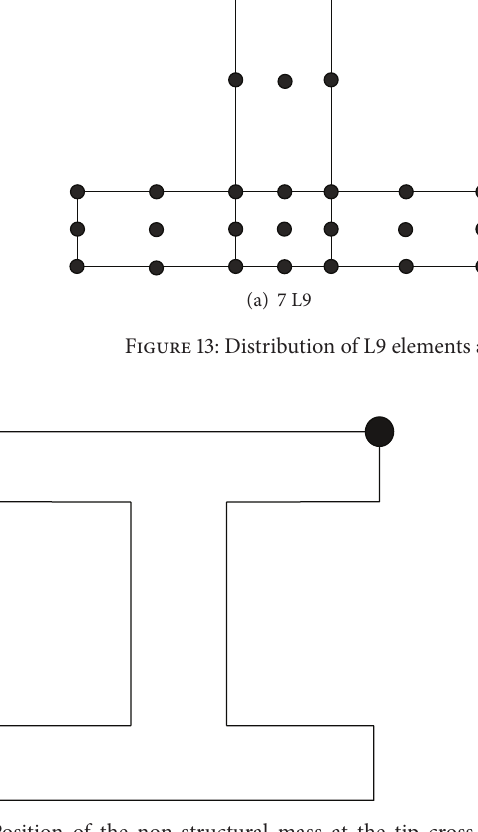
Figure 14: Position of the non-structural mass at the tip cross- section of the I-shaped